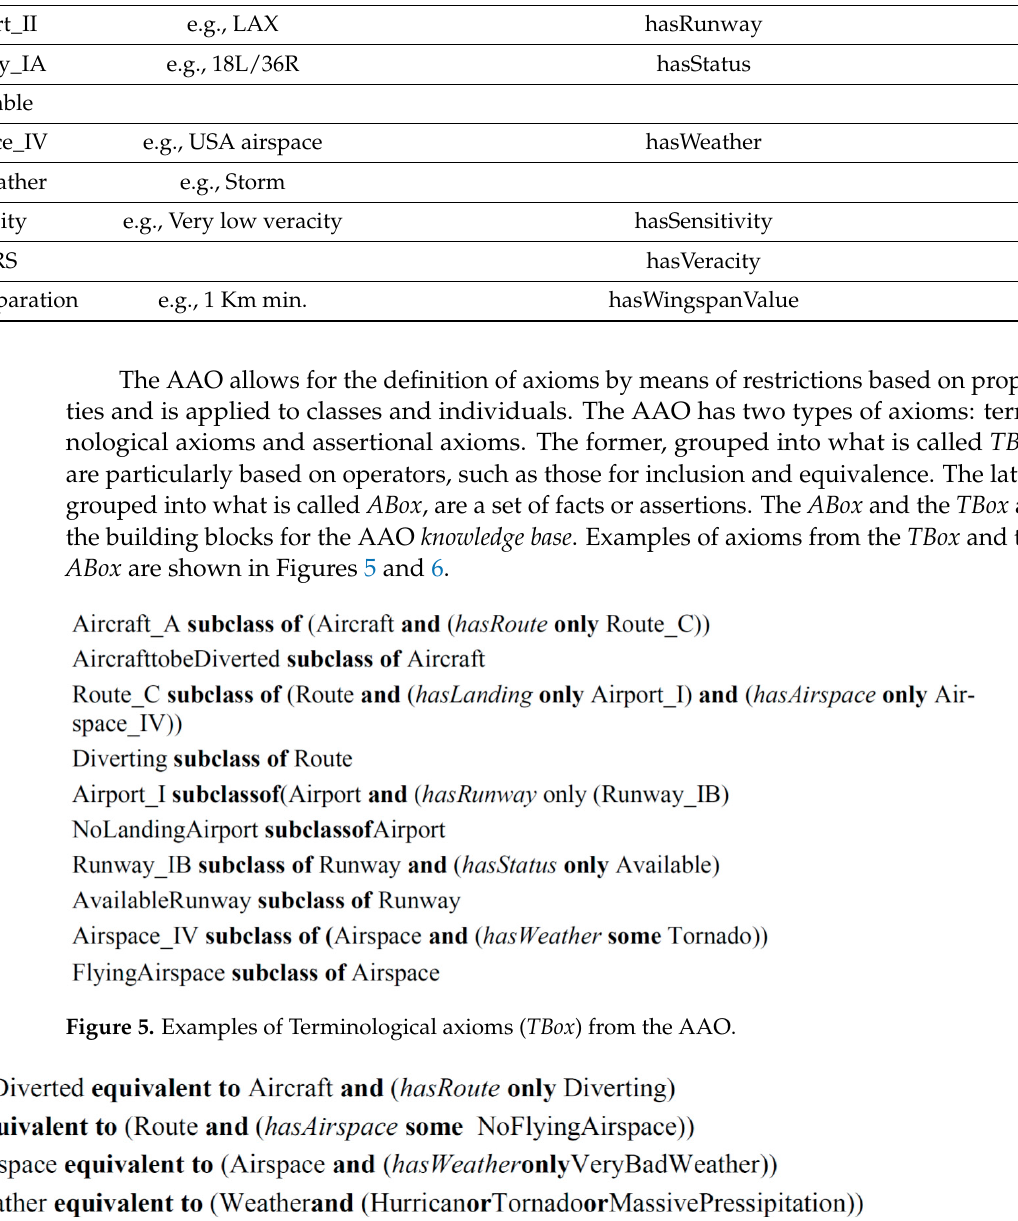
Figure 7. Examples of inferred classes. 4.2. Veracity Assessment Veracity of a piece of information is assessed by a composite criterion, which aggre- gates metrics that are related to its source(s). The metrics are extracted from confusion matrices because they are comprised of sensor reports that are based on how well a given sensor reflects the actual state of the subject being sensed. The statistical classification approach using the confusion matrices is well understood and used [51], sometimes with a different name, in other domains, such as machine learning, to analyze system accuracy by deferring and identifying elements. In a Bayesian framework, confusion matrices are modeled as leaf nodes of a graph that reflect the causal relationship between reality and what the sensor reports it to be. The ancestor nodes would perform the aggregation of the criteria, which ultimately would be used in the assessment of veracity and other charac- teristics important to ATM systems. Examples of attributes that can be aggregated in this scheme include sensitivity, accuracy, precision, credibility, and timeliness.